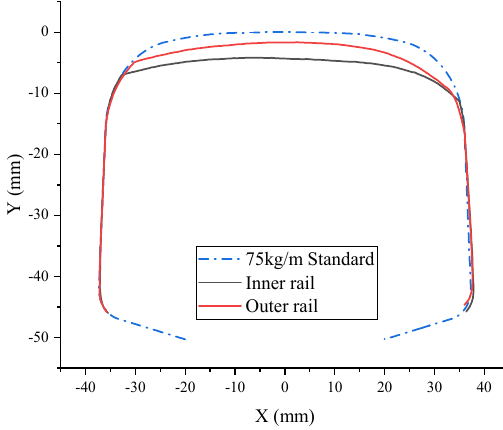
Figure 9. Measured profile after grinding by MiniProf.